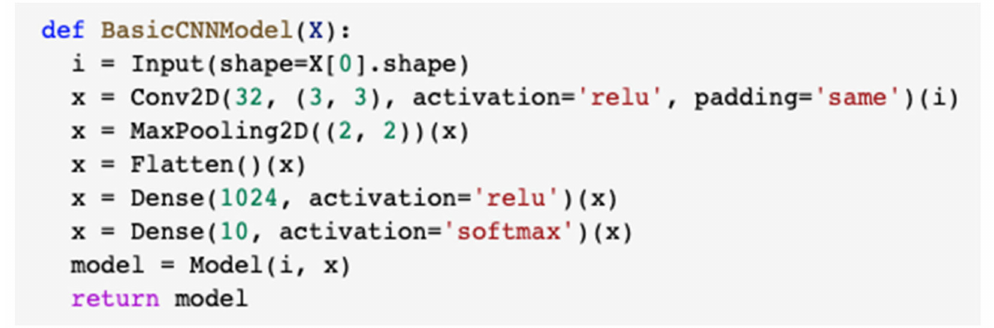
Figure A4. Basic CNN Model